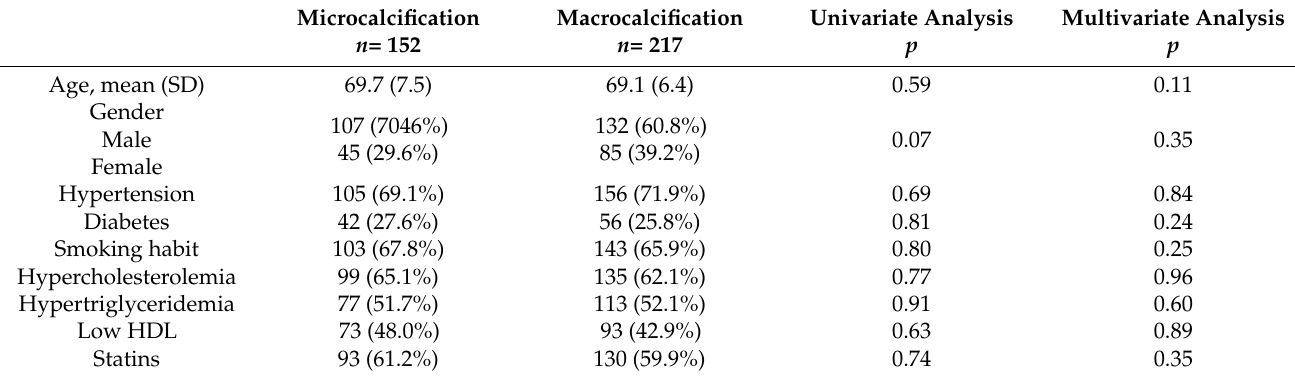
Table 3. Correlation between the type of calcifications and risk